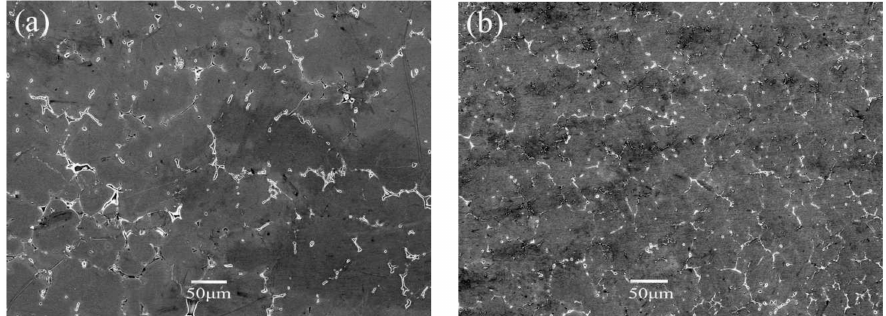
Figure 2. Scanning electron microscopy (SEM) microstructures of as-cast Al-5Mg- x Zr alloys: ( a ) x = 0; ( b ) x =